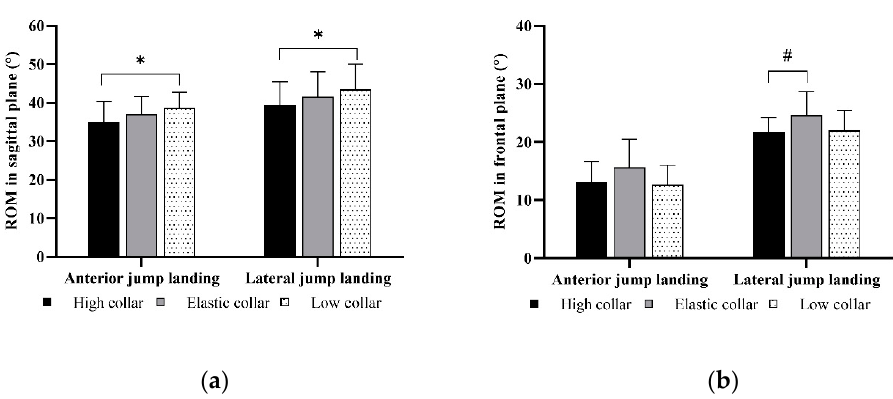
Figure 3. Range of motion (ROM) in the sagittal ( a ) and frontal ( b ) planes for both anterior and lateral jump landings in three shoe conditions: high collar, elastic collar, and low collar. * indicates a significant pairwise difference between the high collar and low collar; # indicates a significant pairwise difference between the high collar and elastic collar.